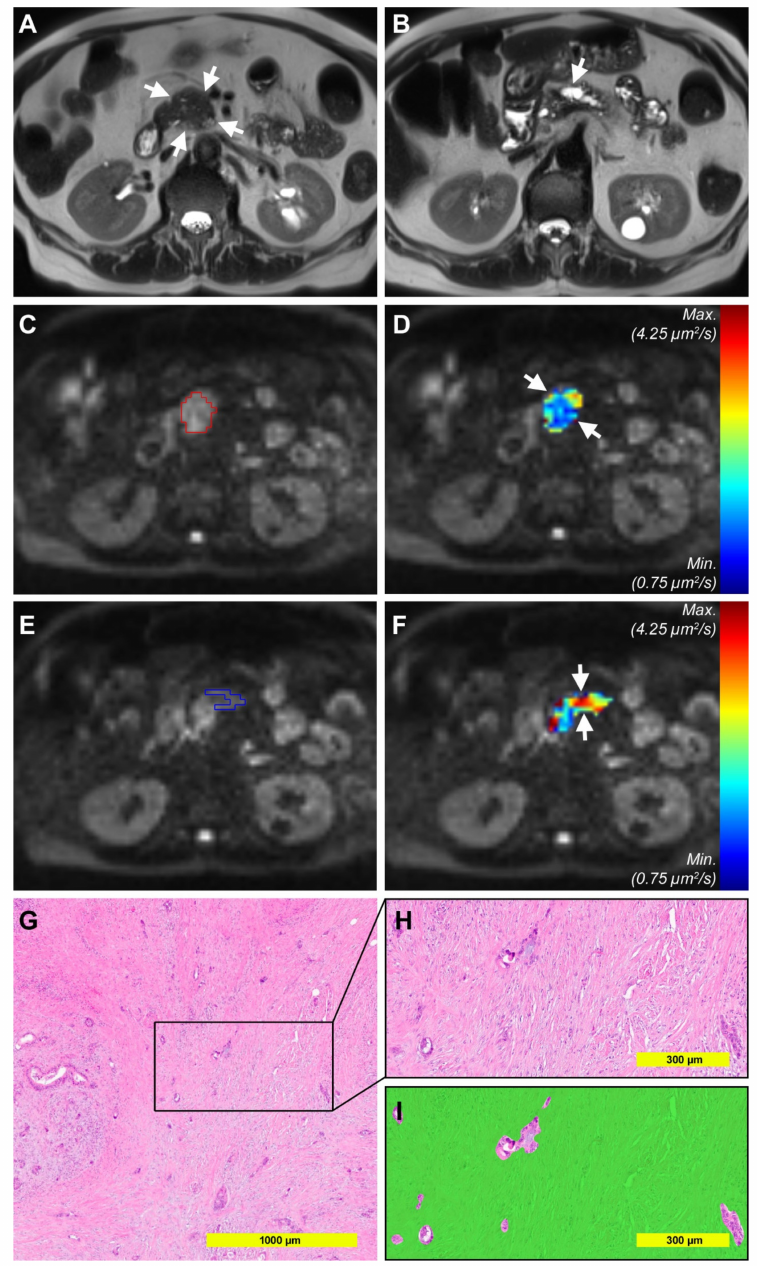
Figure 5. Example pictures of a 74-year-old female patient with high stroma percentage. ( A ) Axial Half-Fourier-Acquired Single-shot Turbo spin Echo (HASTE) T2-weighted image showing the isointense tumor in the pancreatic head ( arrows ). ( B ) Axial T2-weighted image at the level of the pancreatic corpus showing upstream dilatation of the main pancreatic duct ( arrows ). ( C ) Di ff usion-weighted image (DWI) with b-value 1000 s / mm 2 with the volume of interest surrounding the tumor (VOI tumor , red ) from reader 1. ( D ) Corresponding color-coded D-map. Note that the tumor is colored in blue, representing low D values. Mean D tumor for both readers was 1.544 µ m 2 / s. ( E ) DWI with b-value 1000 s / mm 2 with the volume of interest surrounding the upstream parenchyma (VOI upstream , blue ) from reader 1, taking care to avoid the dilated pancreatic duct. Mean D upstream for both readers was 2.855 µ m 2 / s. ( F ) Corresponding color-coded D map. ( G , H ) Cutouts of a representative HE section from the histopathological specimen. ( I ) Segmented stroma compartment ( green ) shows high stroma percentage (90% for the analyzed